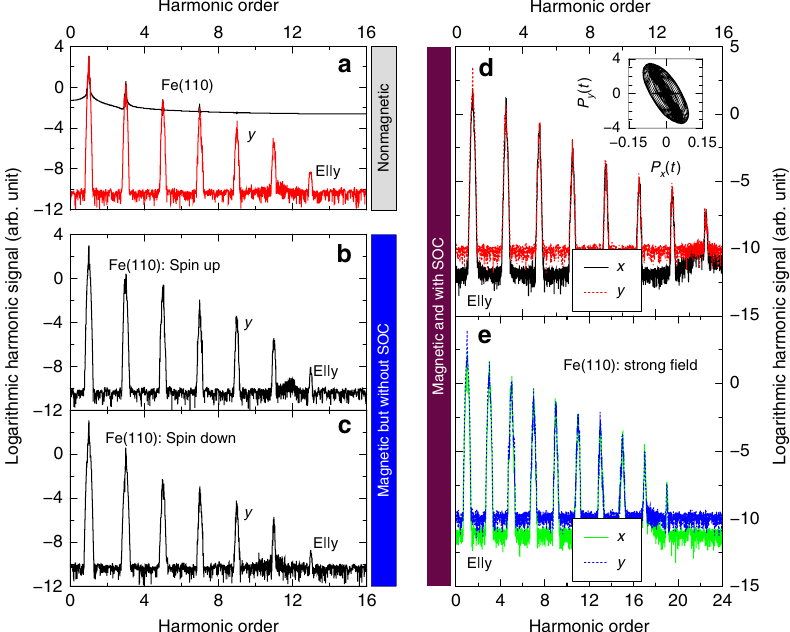
Fig. 2 Harmonic signals under different magnetic ordering and laser amplitudes. a HHG signal from a nonmagnetic Fe monolayer. The laser E- fi eld is along the y axis, with ħ ω = 2.0 eV, τ = 60 fs and fi eld amplitude E 0 = 0.09V/Å, for the results in this fi gure. The top curve is obtained without using the window function, while the bottom is processed with the window function. b HHG from the spin-up channel in a magnetic Fe monolayer. The spin – orbit coupling is not included. c Similar to b , but from the spin-down channel. d HHG signal with spin-polarized electrons and spin – orbit coupling. The solid and dashed lines denote the signals along the x and y axes, respectively. The spin is orientated perpendicular to the Fe(110) surface. Inset: Phase diagram of P x ( t ) versus P t ). e Same as d but with E = 0.15V/Å, where high harmonics up to 19th order are y ( 0